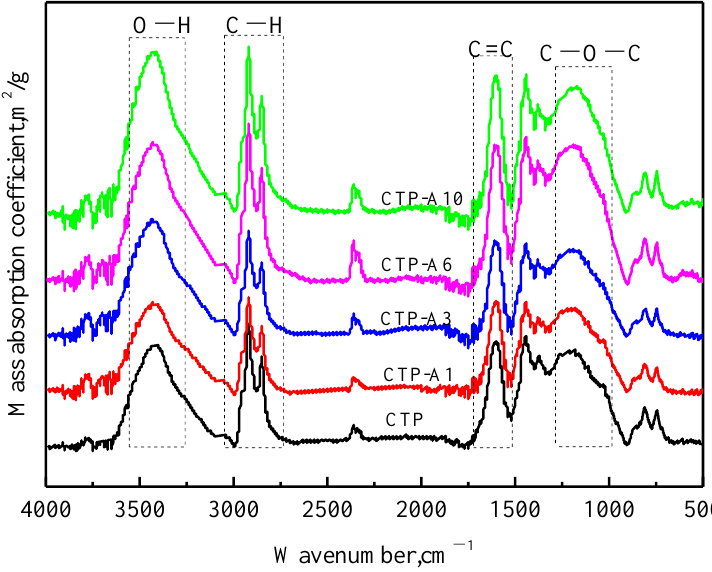
Figure 3. FTIR spectra of original CTP and catalytic oxidation CTP. (CTP, raw CTP; CTP-A1, AlCl 3 catalyzed air oxidation for 1 h; CTP-A3, AlCl 3 catalyzed air oxidation for 3 h; CTP-A6, AlCl 3 catalyzed air oxidation for 1 h; CTP-A10, AlCl 3 catalyzed air oxidation for 10 h.).